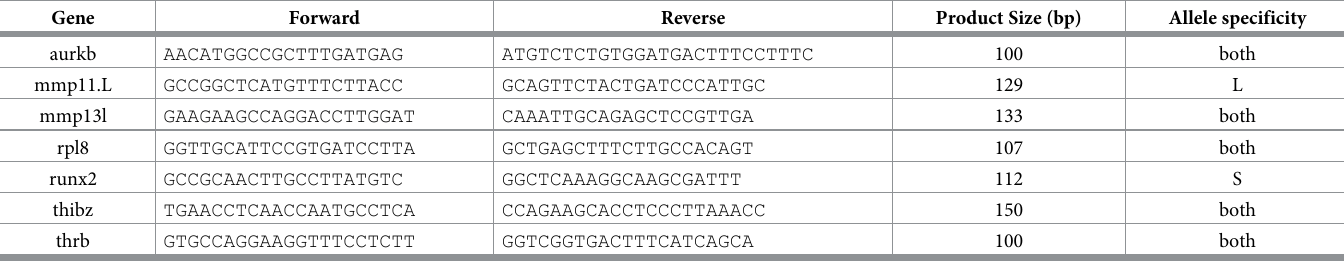
Using our precocious metamorphosis assay system, we treated X . laevis 1wk-PF tadpoles